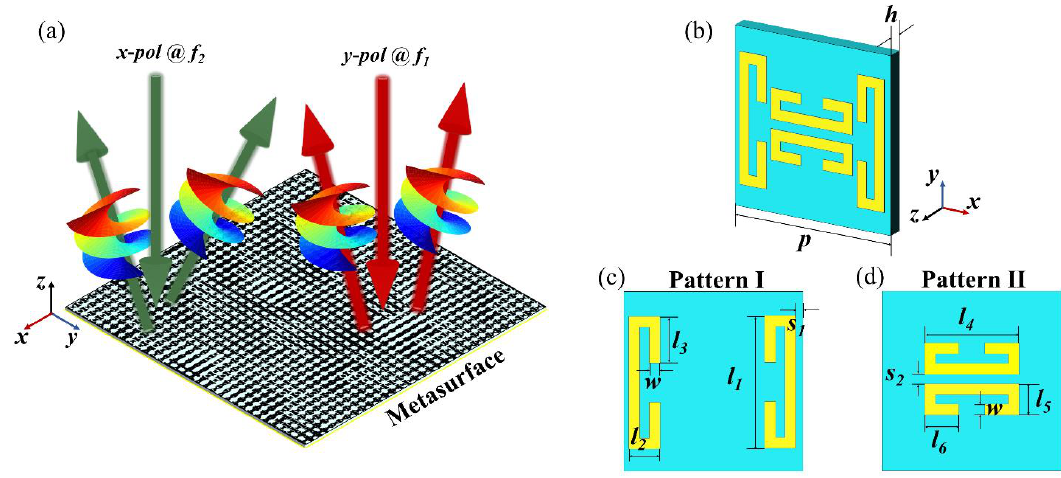
Figure 1. ( a ) Schematic illustration of the vortex beam generator based on the 3-bit coding reflective metasurface. ( b ) Three-dimensional view of the metasurface unit cell; the unit cell is a combination of ( c ) Pattern I and ( d ) Pattern II.